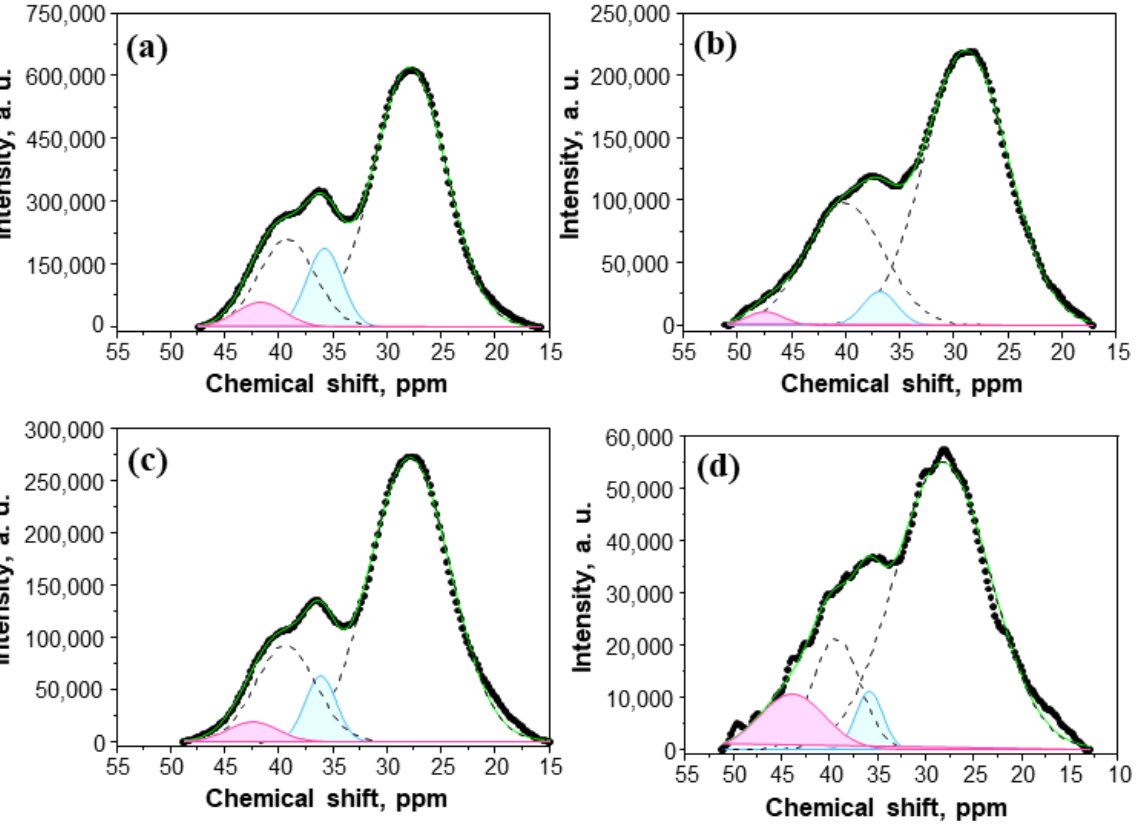
Figure 4. Aliphatic region of the 13 C MAS spectra of: ( a ) neat PA6, ( b ) Al10, ( c ) Cu10, and ( d ) Mg10. The two dashed curves represent the combination of the resonances (C4, C2 + C3) and (C1 + C5) from the amorphous regions. The peaks shaded in blue and pink areas represent the C5 and C1 signals, respectively, located in more ordered domains. The chemical shifts of all resonance lines are tabulated in Table 3.